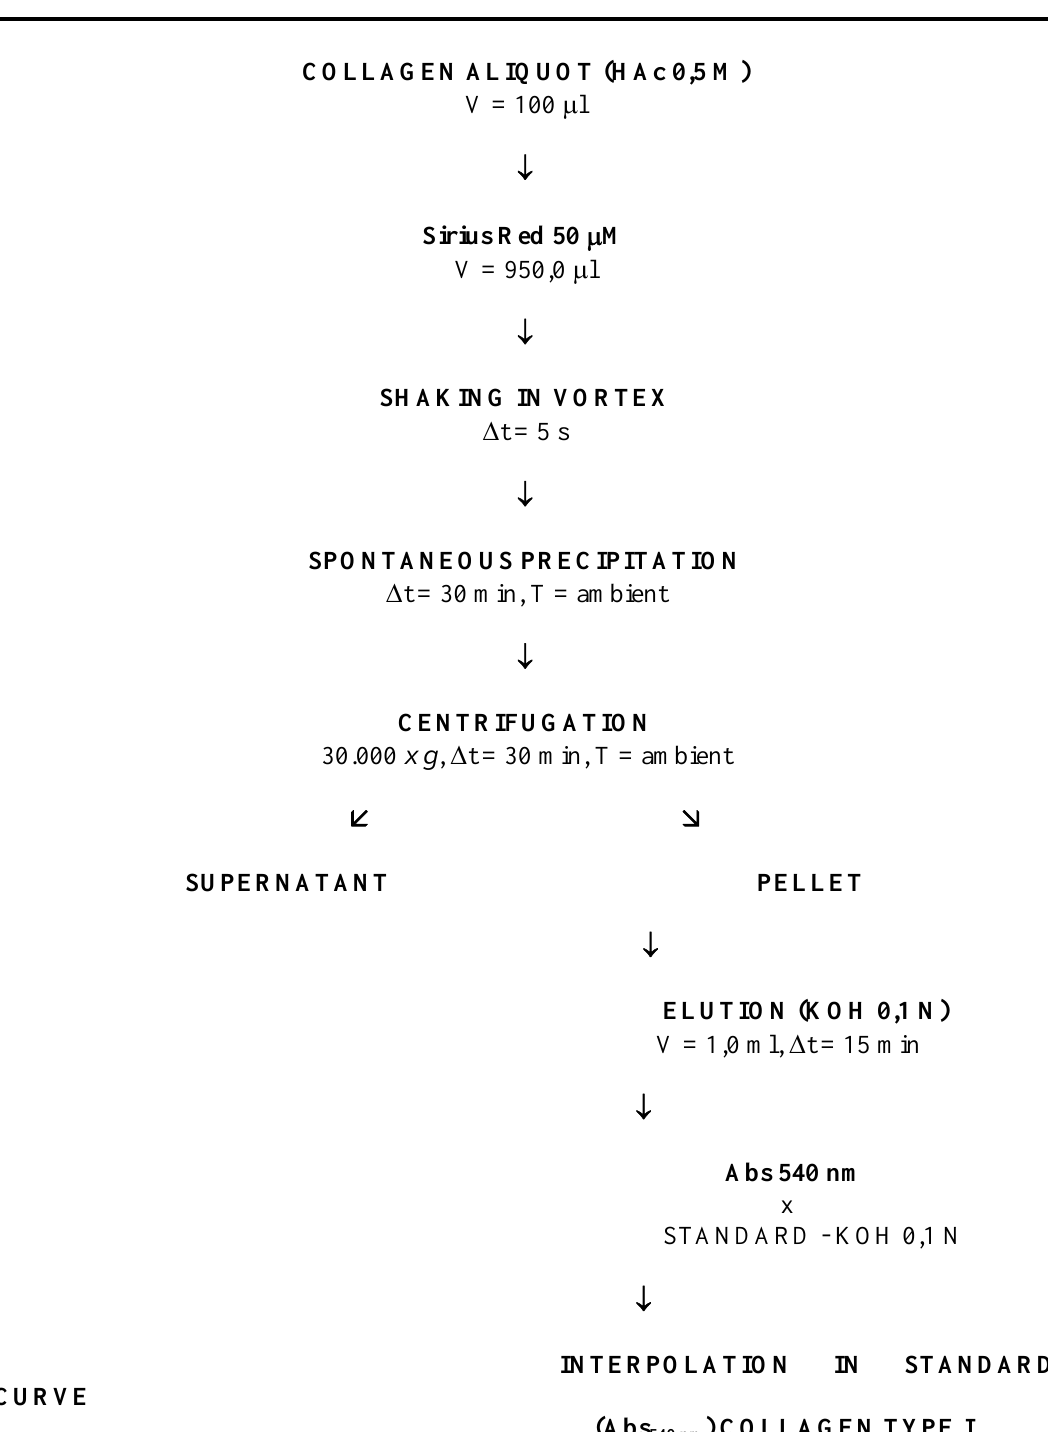
FIGURE 5 - Process of collagen chromogenic precipitation reaction with the dye Sirius Red F3B in aliquots from fibroblast